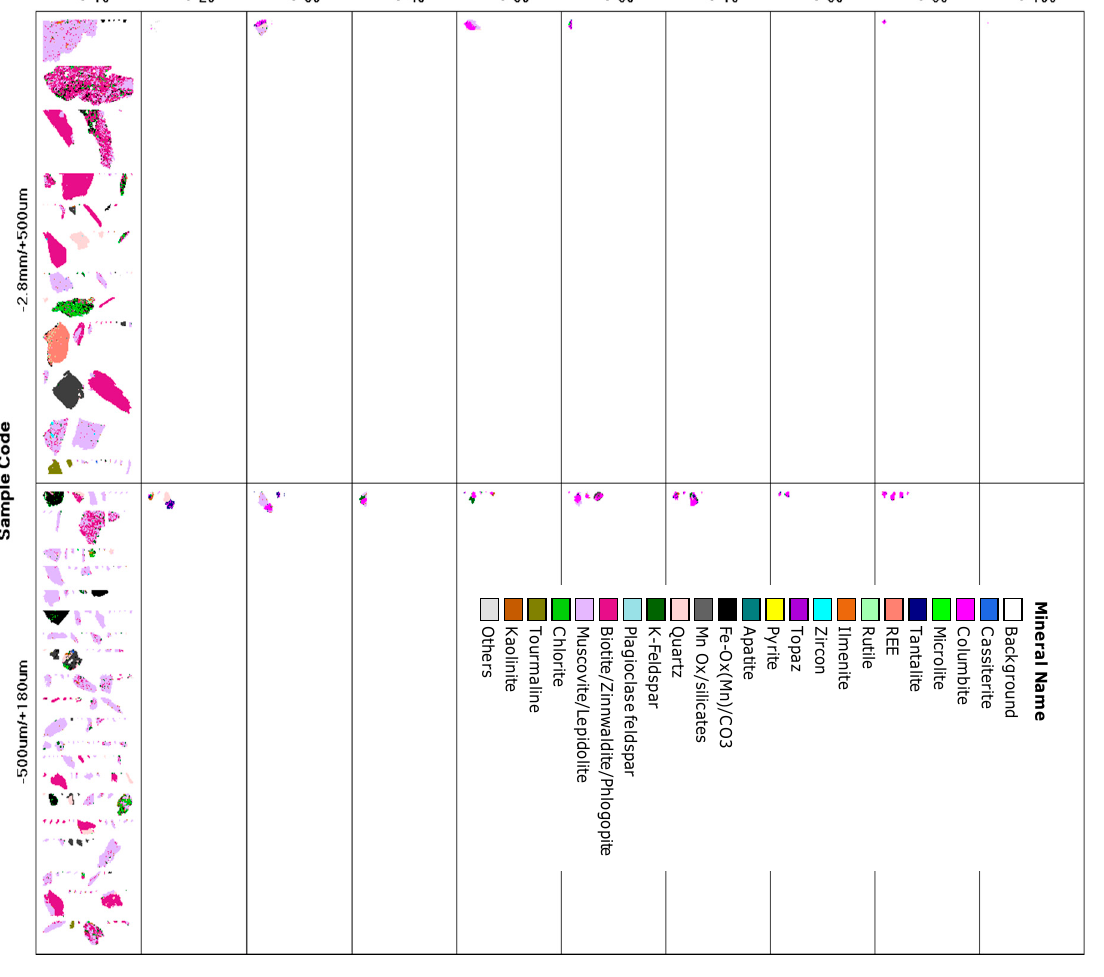
Figure 6. Image Grids of columbite liberation in the two HLS products.